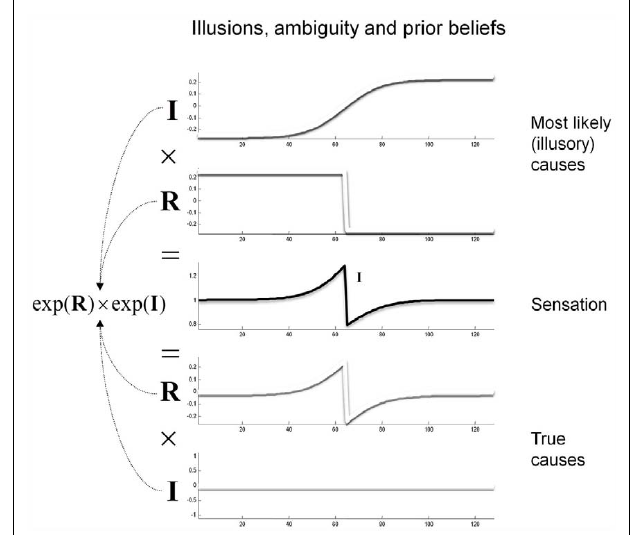
FIGURE 2 | Contributions to luminance. Luminance values reaching the retina are modeled as a multiplication of illuminance from light sources and reflectance from the surfaces in the environment.The factorization of luminance is thus an ill-posed problem. One toy example of this degeneracy is shown here; the same stimulus can be produced by (at least) two possible combinations of illuminance and reflectance. Prior beliefs about the likelihood of these causes can be used to pick the most likely